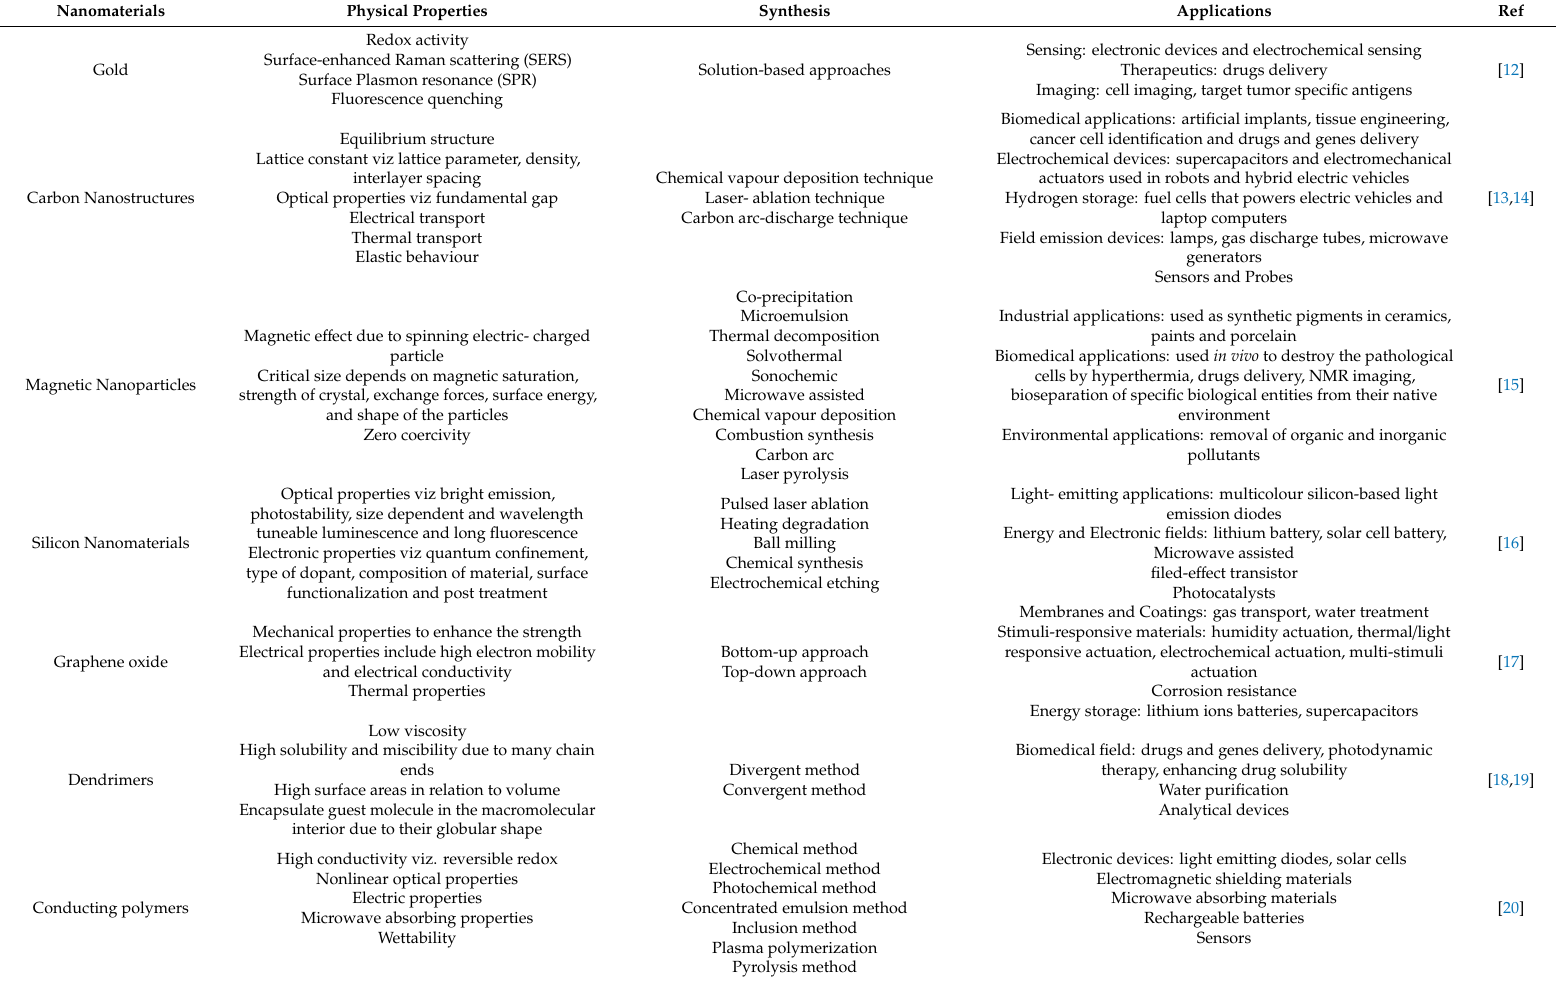
Table 1. Properties, and synthesis of di ff erent types of nanomaterials used in sensors fabrication and other applications.